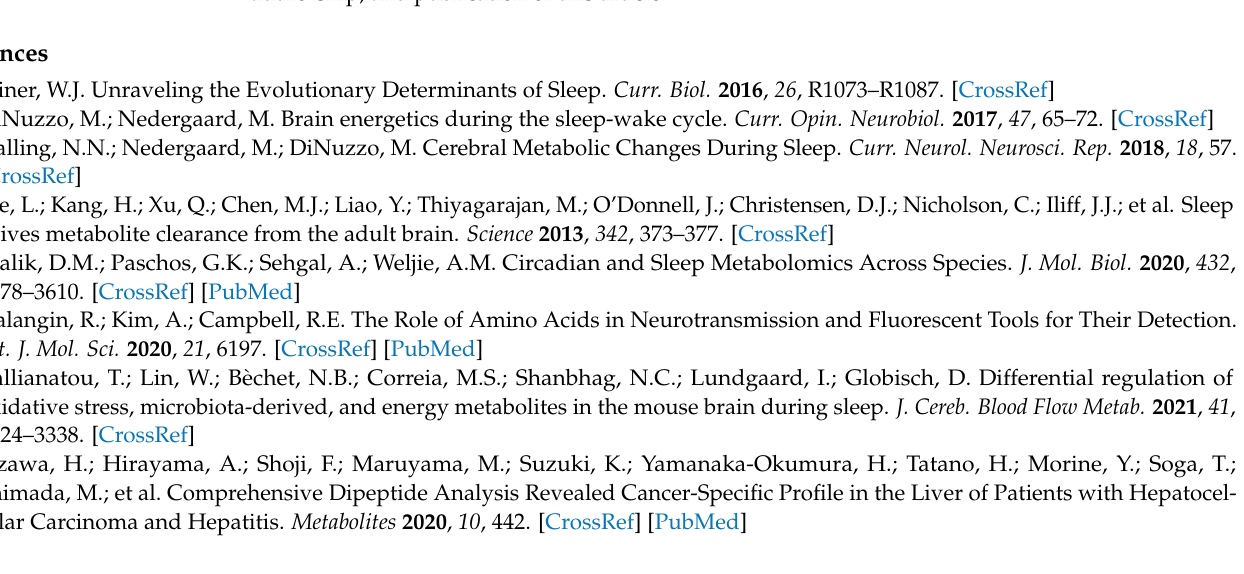
tion of the dipeptides Ile-Tyr, Tyr-Ile and Tyr-Leu, Figure S7: Summary of the presented significant metabolites in all investigated brain regions, Table S1: Structure validation of significantly altered amino acid